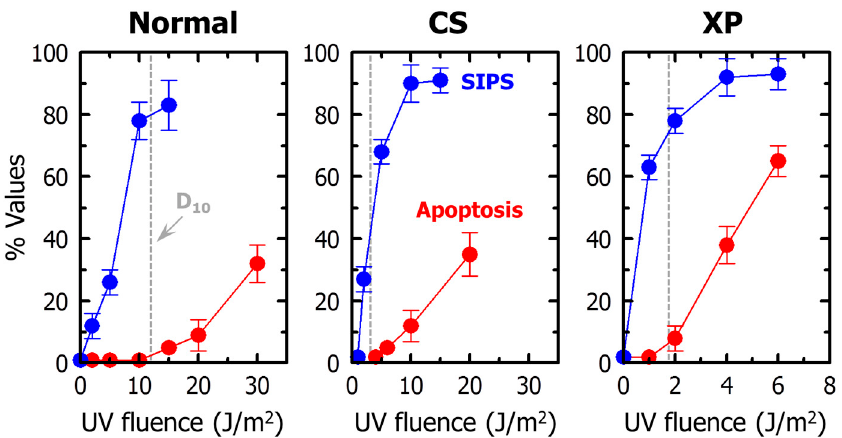
Figure 3. Induction of SIPS (blue circles) and apoptosis (red circles) by UV in human normal, Cockayne syndrome (CS), and xeroderma pigmentosum (XP) fibroblast strains. Dashed lines show fluences of UV that induced 90% effect in the colony formation assay. The results are reproduced from [54] with permission. D 10 , 10% “survival” in the clonogenic assay.